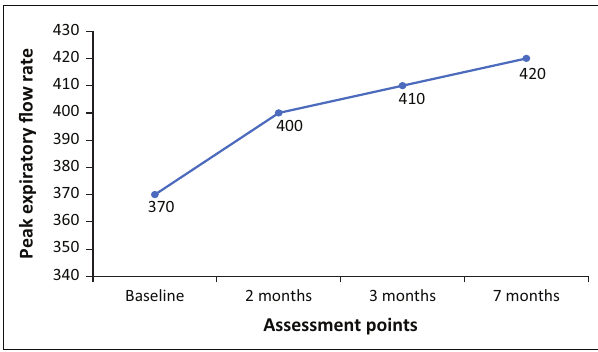
FIGURE 1: Changes in peak expiratory flow rate for Mrs K over a 7-month follow- up period.